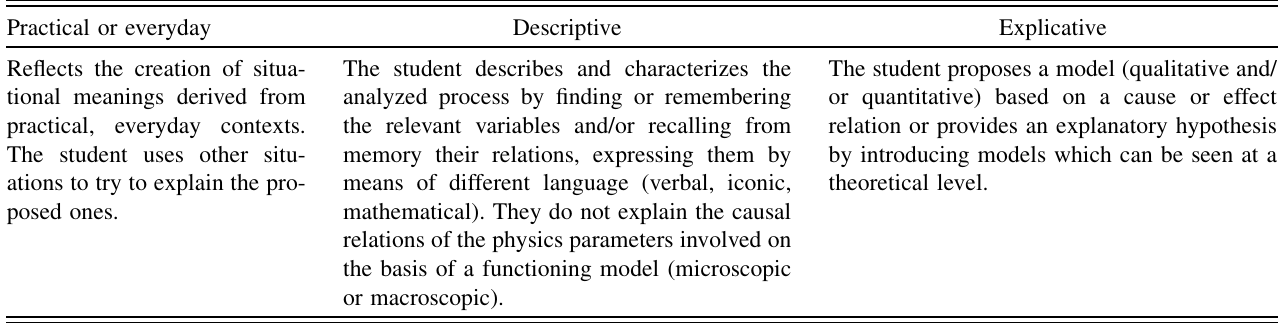
INVESTIGATING THE QUALITY OF MENTAL . . TABLE I. Categories of mental models deployed by students when tackling the questionnaire and the related reasoning procedures. Practical or everyday Descriptive Explicative Reflects the creation of situa- tional meanings derived from practical, everyday contexts. The student uses other situ- ations to try to explain the pro- posed ones.